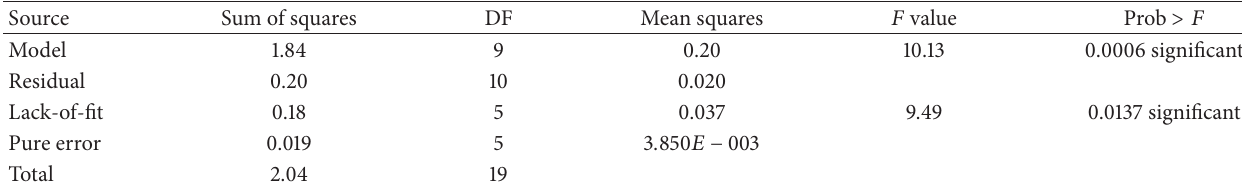
Table 5: Analysis of variance for the quadratic model of impact strength.